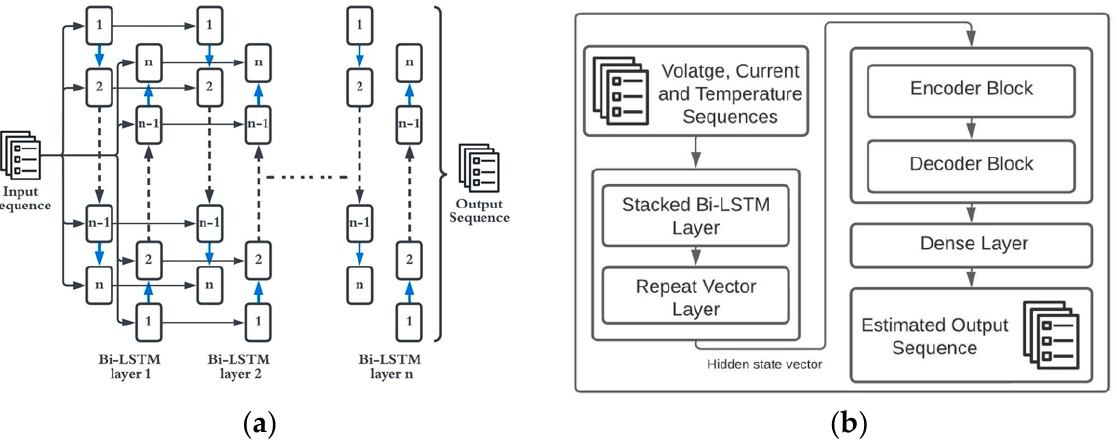
Figure 6. Schematic Diagram ( a ) Stacked Bi–LSTM structure. ( b ) Stacked Encoder–Decoder Archi- tecture.